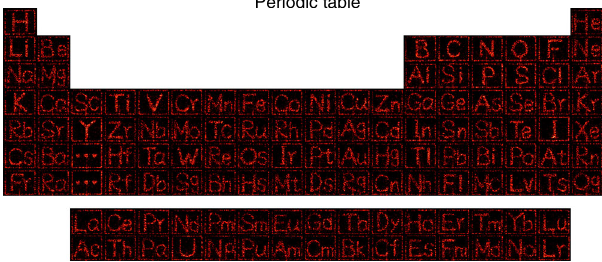
Fig. 4 The reprogrammable meta-hologram. The holographic images of periodic element table. Each element in this table is one holographic image that is generated with the same metasurface in Fig.